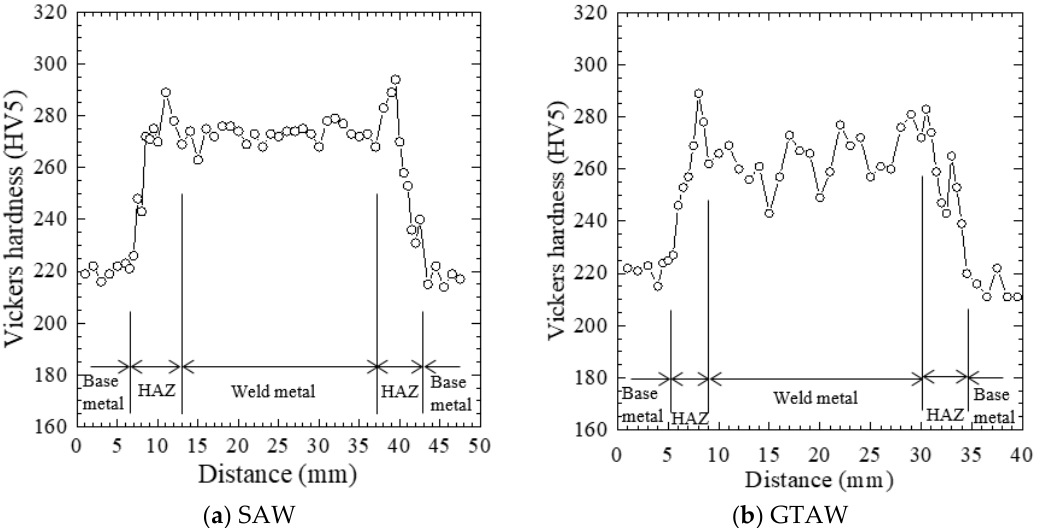
Figure 14. Hardness profiles of the SAW ( a ) and GTAW ( b ) weld joints.